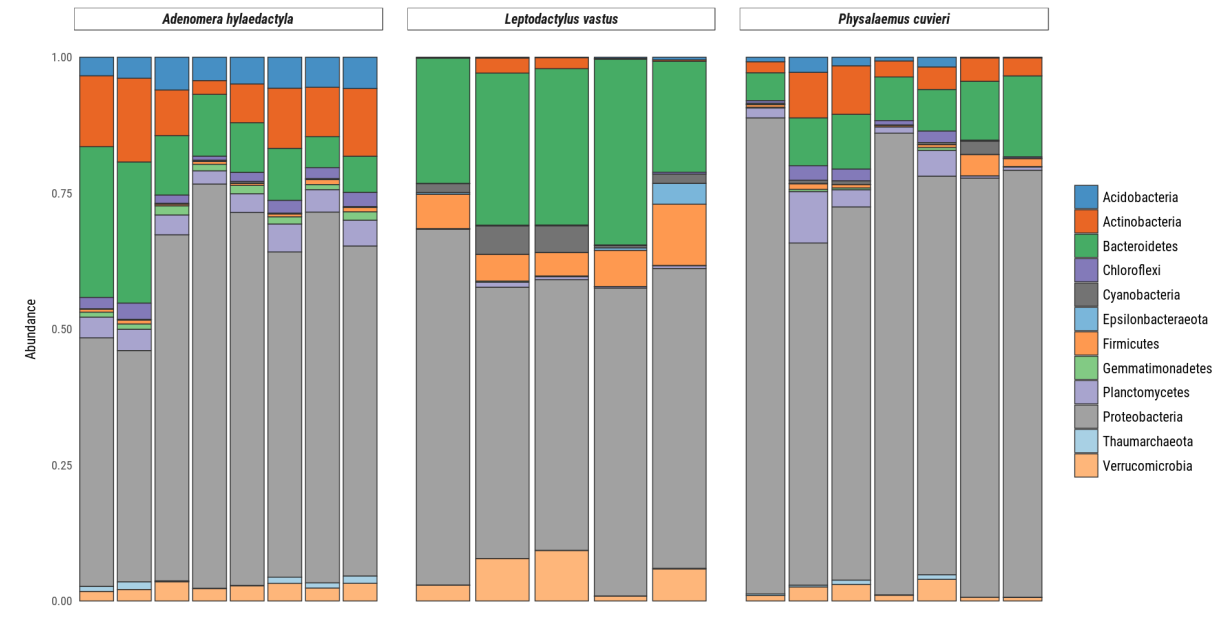
Figure 4. Relative abundance of bacteria and archaea amplicon sequence variants at phylum levels present in frog foam nests. Stacked bar plot of the relative abundance above 1%.